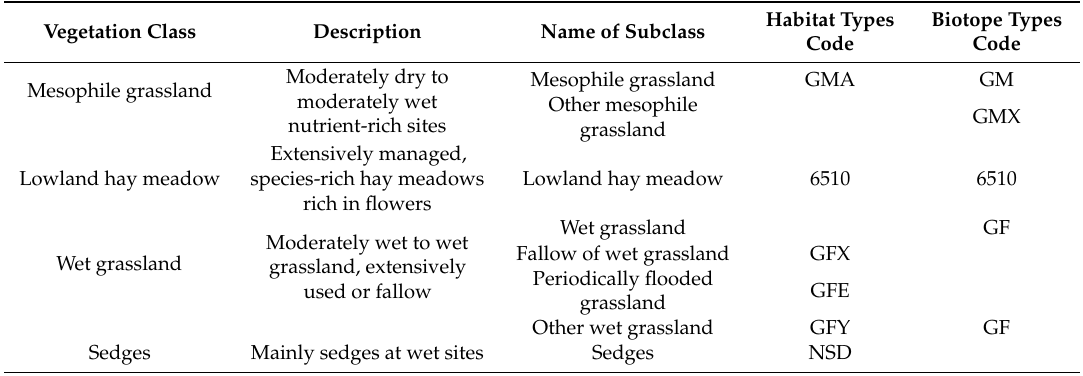
Table A1. Established vegetation classes and their subclasses from habitat mapping (HTC) and biotope type mapping (CIR + BTC)